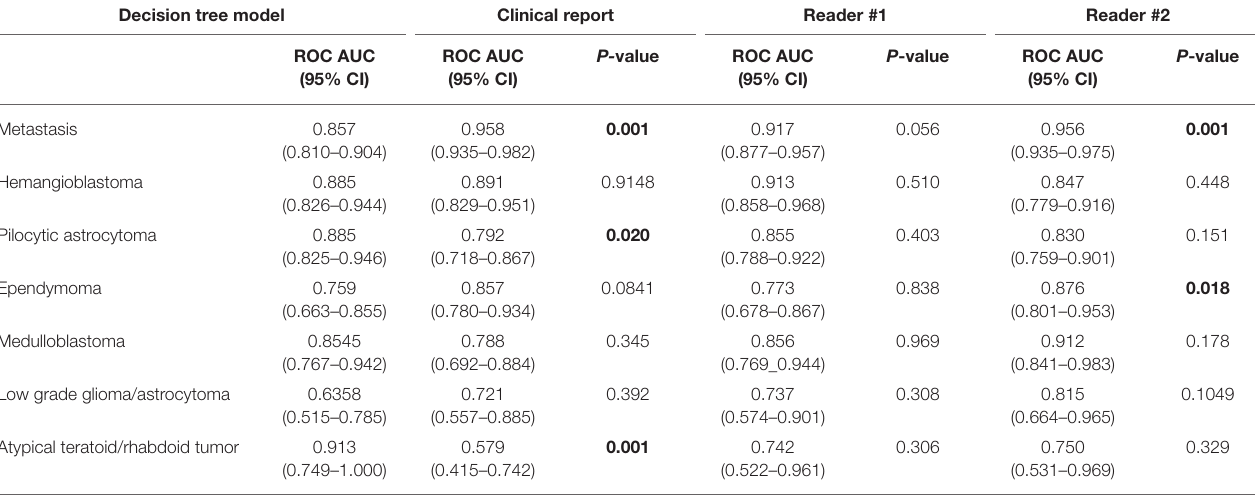
TABLE 3 | Comparing the accuracy of decision tree model ( Figure 5 ) with the official clinical interpretation and independent neuroradiologist reviewers.